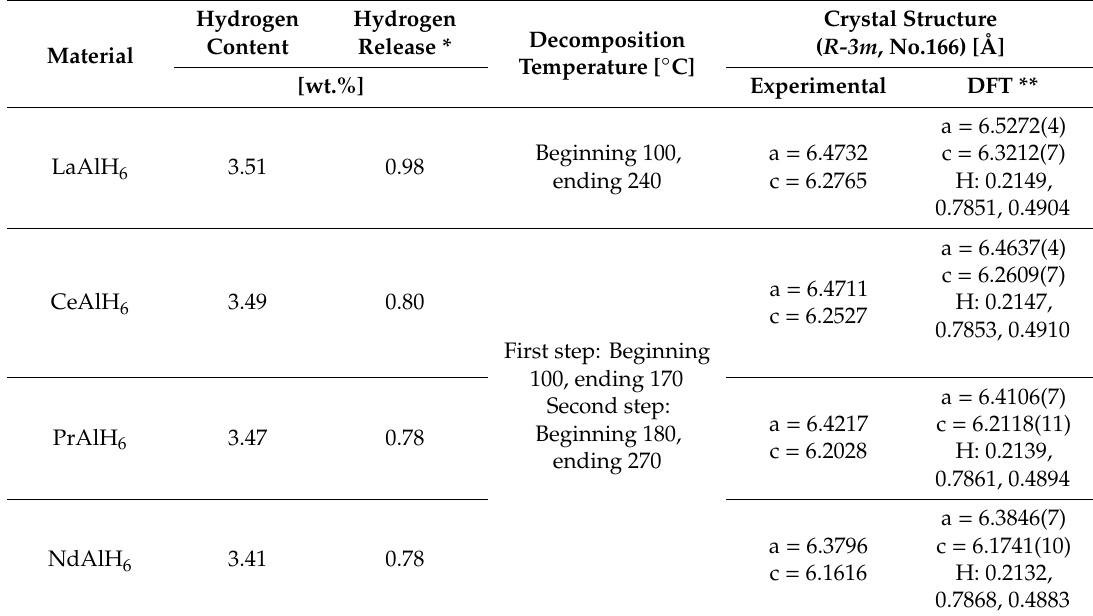
Table 12. Lanthanides-Aluminum Hydrides (MAlH 6 ) relevant data